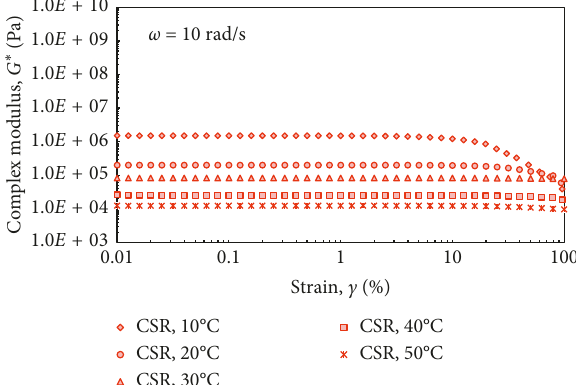
Figure 10: Amplitude sweep experimental test results ( G CSR. Table 3: Summary of amplitude sweep test results: initial G LVE limit.